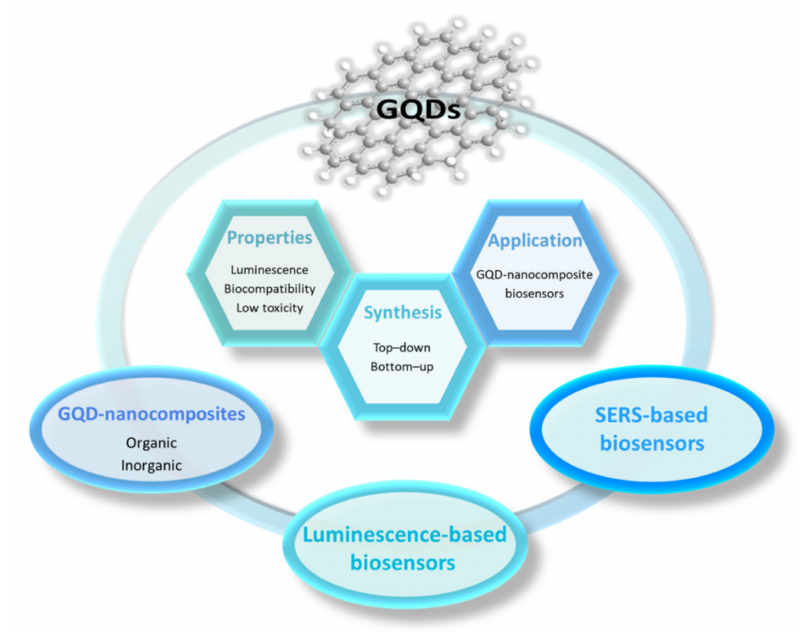
Figure 1. Overview of the main topics about GQD nanocomposites discussed in this